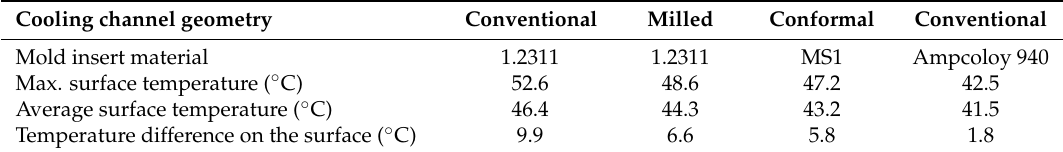
Table 3. The maximum and average surface temperatures and the temperature differences on the surface of the various mold